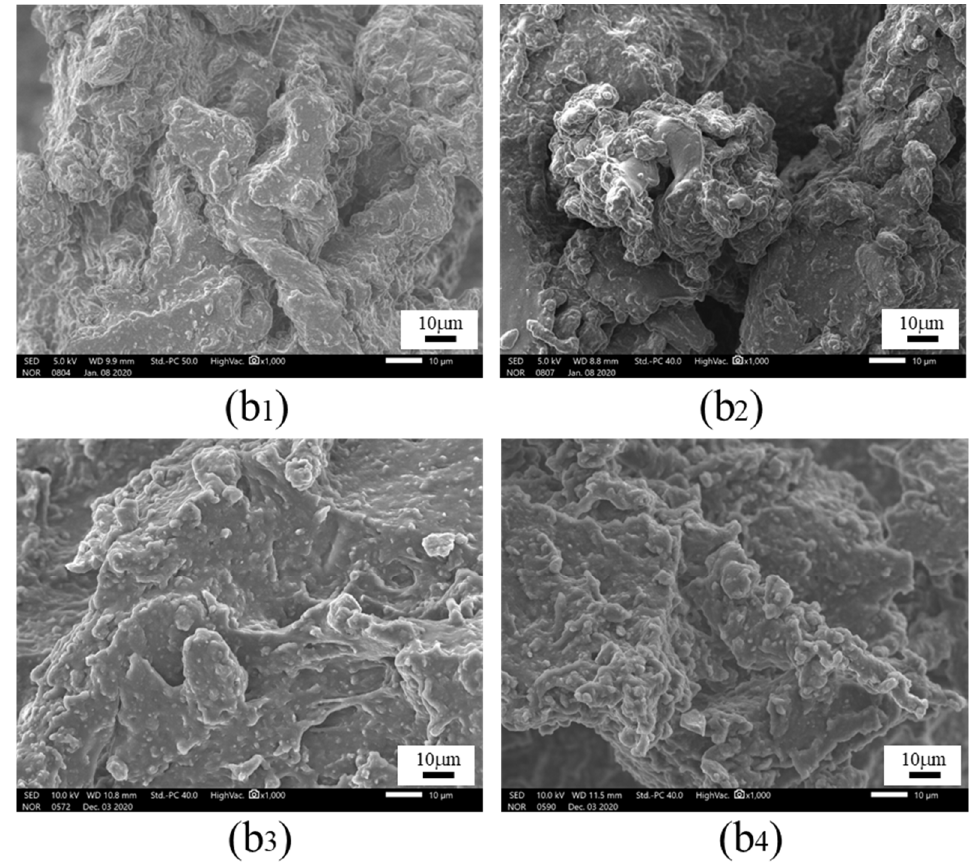
Figure 13. SEM of the failure section: loading ( b1 ) 0 N, ( b2 ) 200 N, ( b3 ) 400 N and ( b4 ) 600 N under the HTAH environment.